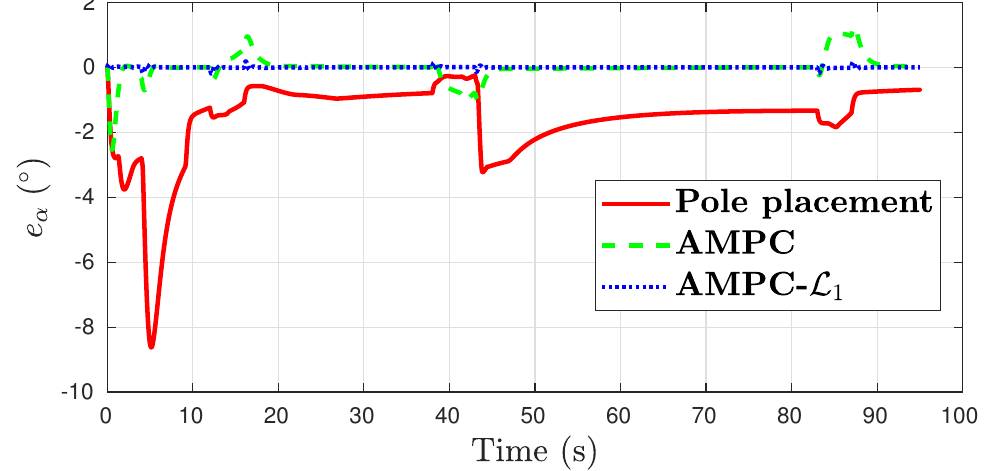
Figure 7. Angle-of-attack tracking error for aerodynamic uncertainty